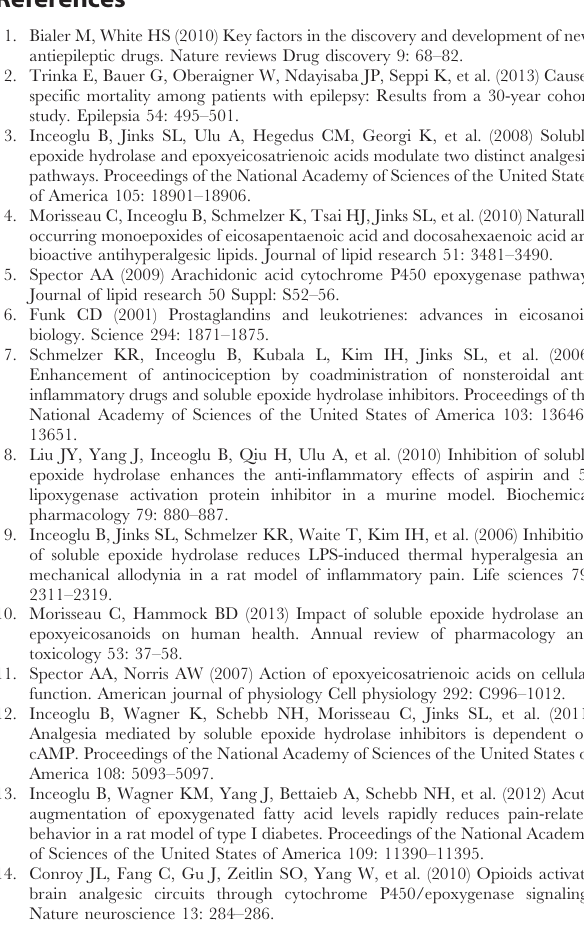
these increases were smaller in magnitude than PTZ induced changes. (TIF) Figure S3 Direct administration of EETs and sEHI into the brain delay onset of PTZ induced seizures. Bar graph of percent change in onset of clonic (black bars) and tonic (gray bars) seizures following intracerebroventricular EETs and TUPS (n= 6–14mice/group) 10 min post administration (see Fig. 6 for 30 min post i.c.v. administration). Even though the profile of EpFAs were studied at 30 min post ic.v. dosing, a small pilot experiment was performed by testing PTZ 10 min after ic.v. administration. In this assay the regioisomeric mixture of EET methyl esters as well as the sEHI were efficacious in delaying the onset of seizures (Kruskal-Wallis One Way ANOVA on Ranks followed by Dunn’s multiple comparison, clonus *p # 0.05, tonus # p # 0.05). (TIF) Table S1 Structure and properties of sEHI used in the study.